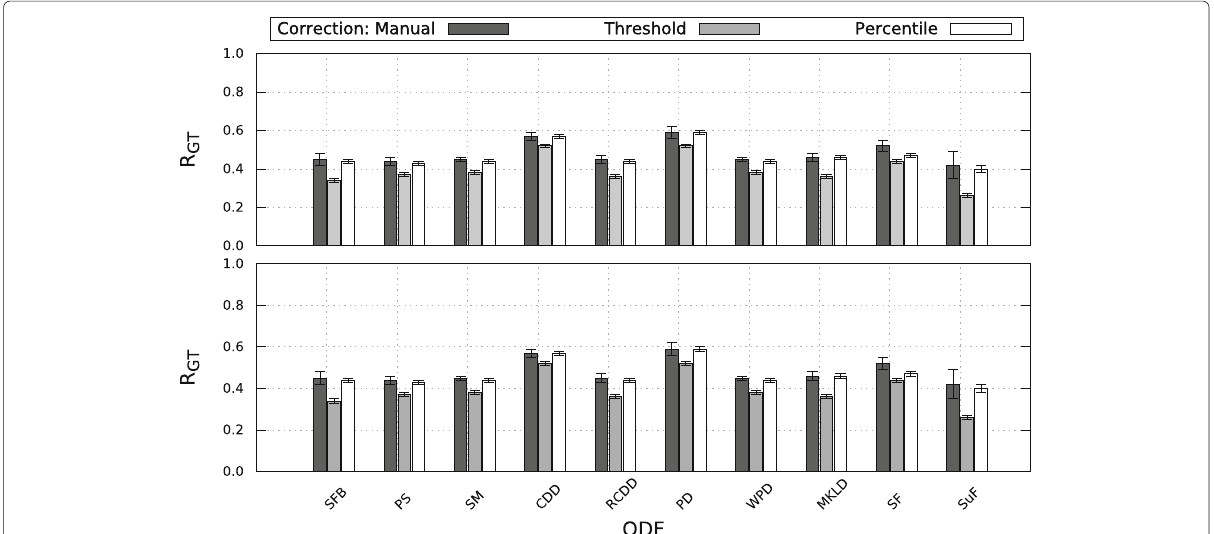
Fig. 6 Graphical representation of the user effort results obtained in terms of the R GT measure for the manual correction and the threshold-based and percentile-based interactive schemes. Top and bottom figures represent the results obtained when considering either threshold-based or percentile-based OSF